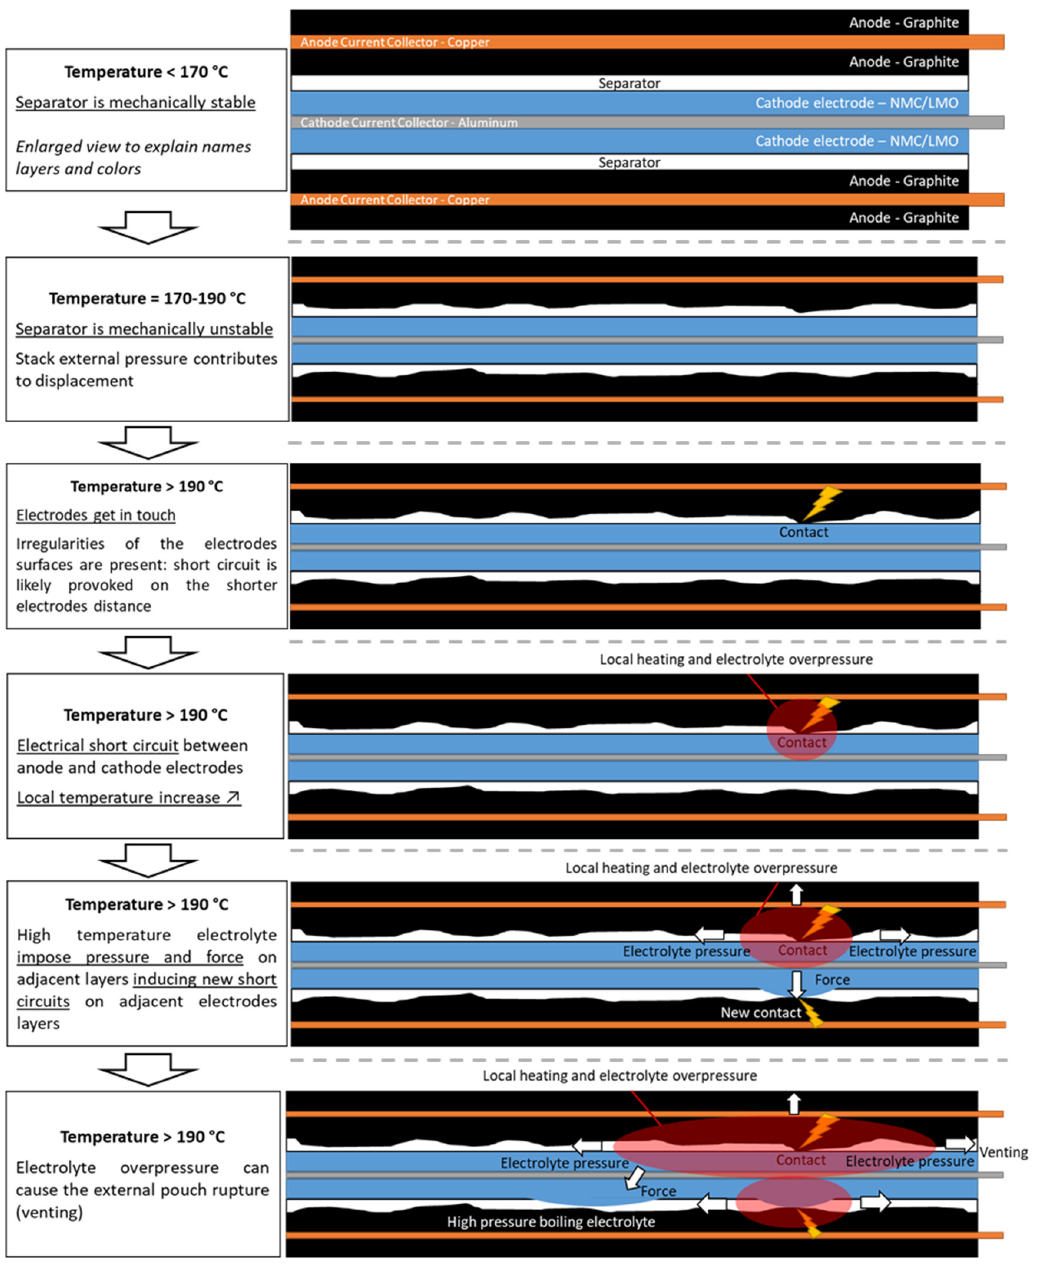
Figure 11. Description of expected internal phenomena occurring during initial warming up phase and TR triggering. Temperature ranges refer to the DSC analysis and not to measured ones during TR propagation test. In fact, during experiment external temperature is measured while described processes are triggered by internal temperatures.